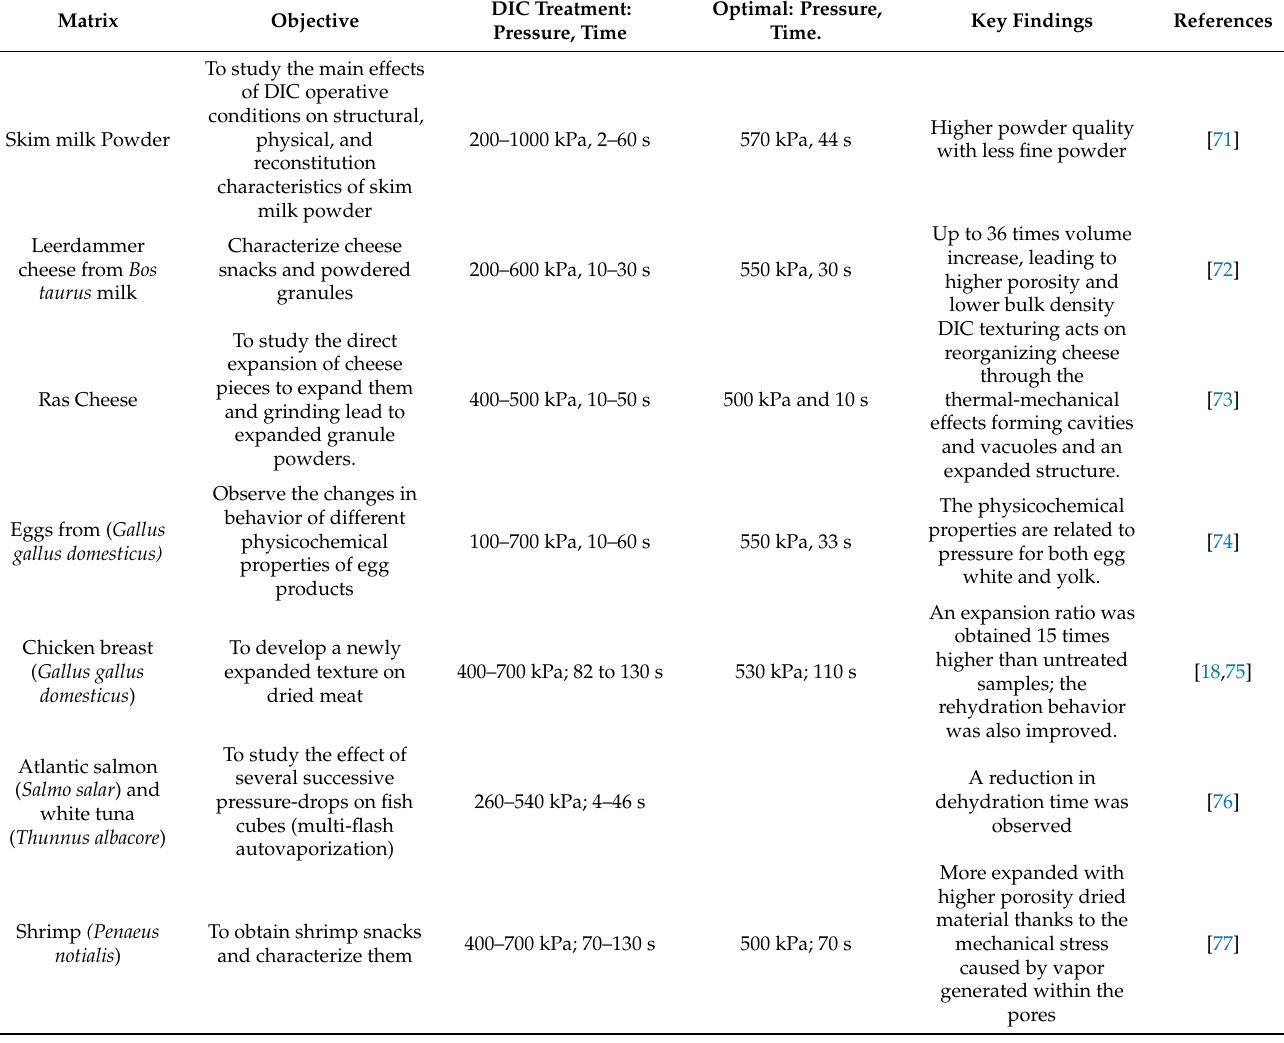
Table 5. Summary of the DIC conditions and some key findings in animal